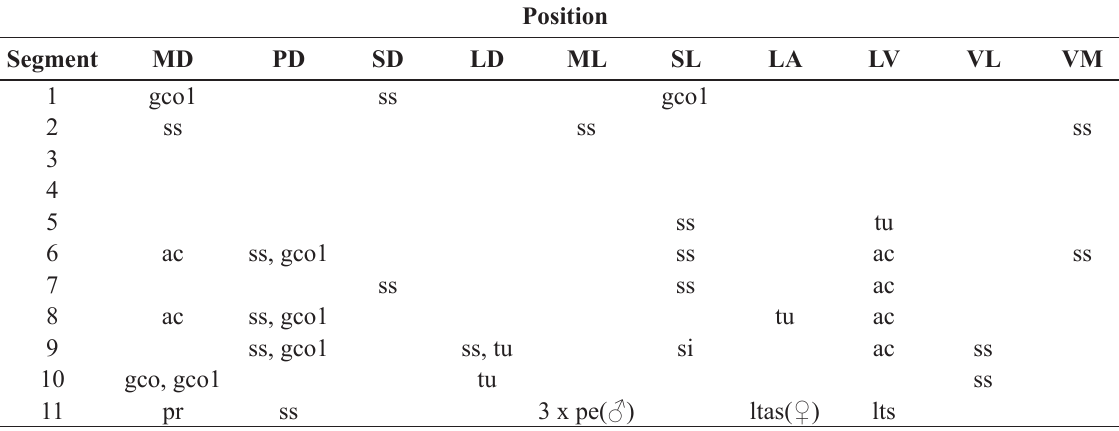
Table 9. Summary of nature and location of sensory spots, glandular cell outlets, tubes and spines arranged by series in Echinoderes hviidarum sp. nov. Abbreviations: LA = lateral accessory; LD = laterodorsal; LV = lateroventral; MD = middorsal; ML = midlateral; PD = paradorsal; SD = subdorsal; SL = sublateral; VL = ventrolateral; VM = ventromedial; ac = acicular spine; gco1 = glandular cell outlet type 1; ltas = lateral terminal accessory spine; lts = lateral terminal spine; pe = penile spines; pr = protuberance; si = sieve plate; ss = sensory spot; tu = tube; ( ♀) = female and ( ♂ ) = male conditions of sexually dimorphic characters.